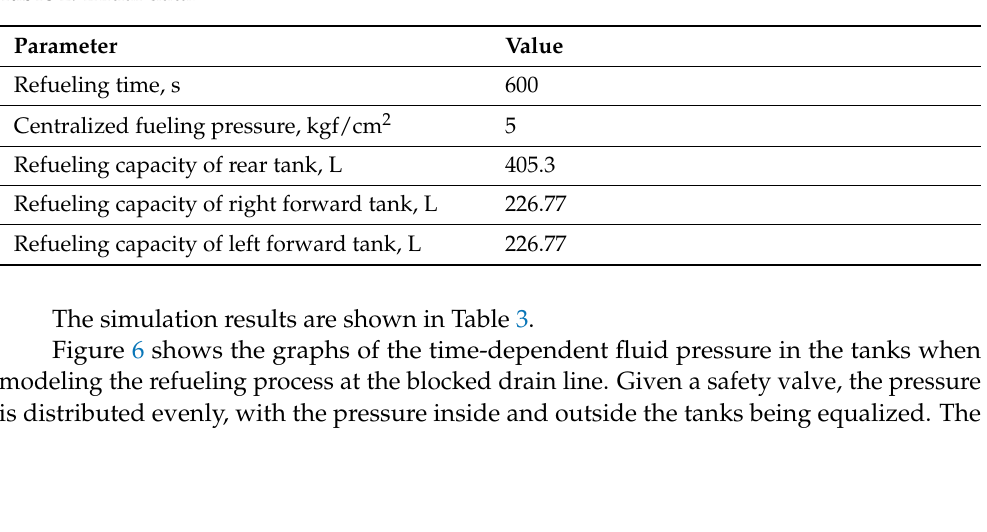
Figure 5. Fuel mass in tanks as a function of operating time.